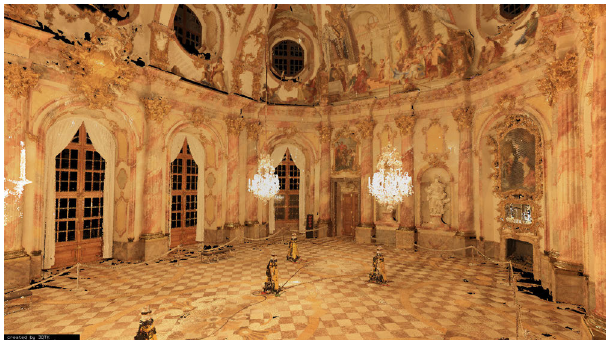
Figure 9: Reconstruction of the Imperial Hall in the W¨urzburg Residence. Visible in the hall are four of the six transmitters from the iSpace localization system.